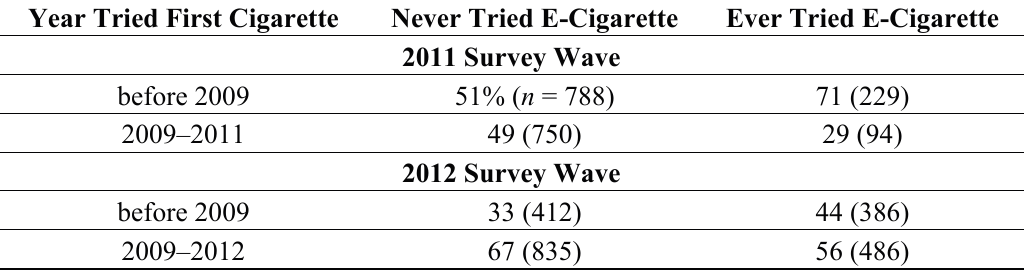
Table 3. Time of trying first cigarette for current smokers, by e-cigarette trialing